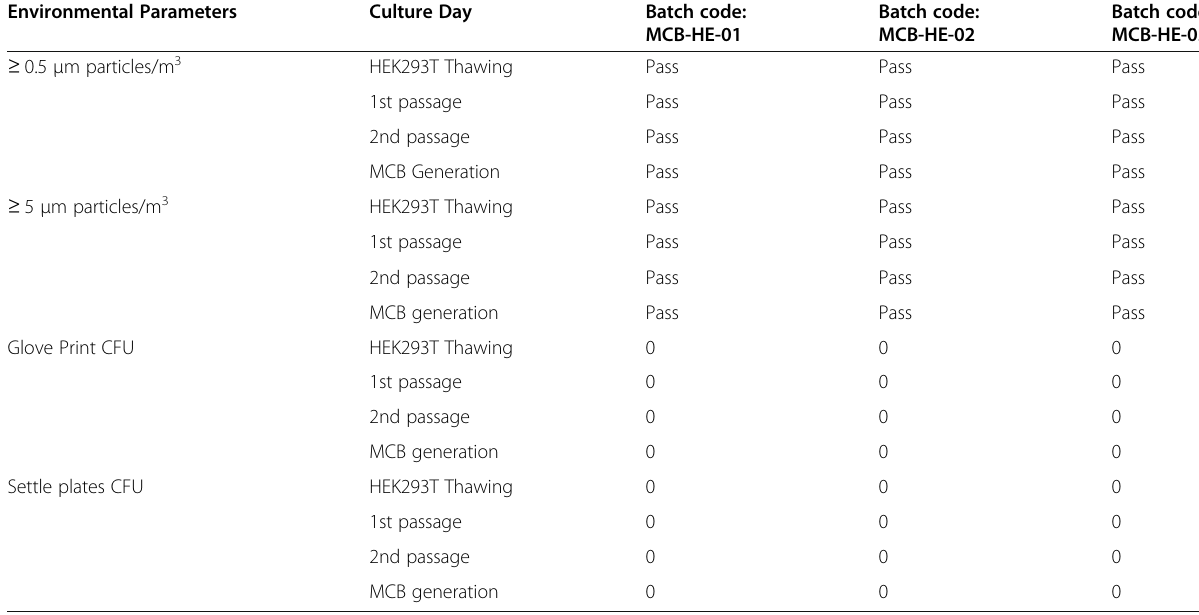
Table 1 Environmental parameters of MCB process validation. Table summarizing the environmental parameters obtained during the production of MCB batches. Airborne particles concentration in the sterile cabinet (Grade A) was measured at each step of the procedure. Particles equal or greater than 0.5 µm met defined acceptance criteria. Particles equal or greater than 5 µm met defined acceptance criteria. Glove prints of personnel operating in the cabinet (Grade A) were sampled at each step of the procedure. No microorganisms were detected in agreement with the acceptance criteria. The presence of airborne microorganisms in the cabinet (Grade A) was monitored at each step of the procedure by using settle plates. No microorganisms were detected on the plates,